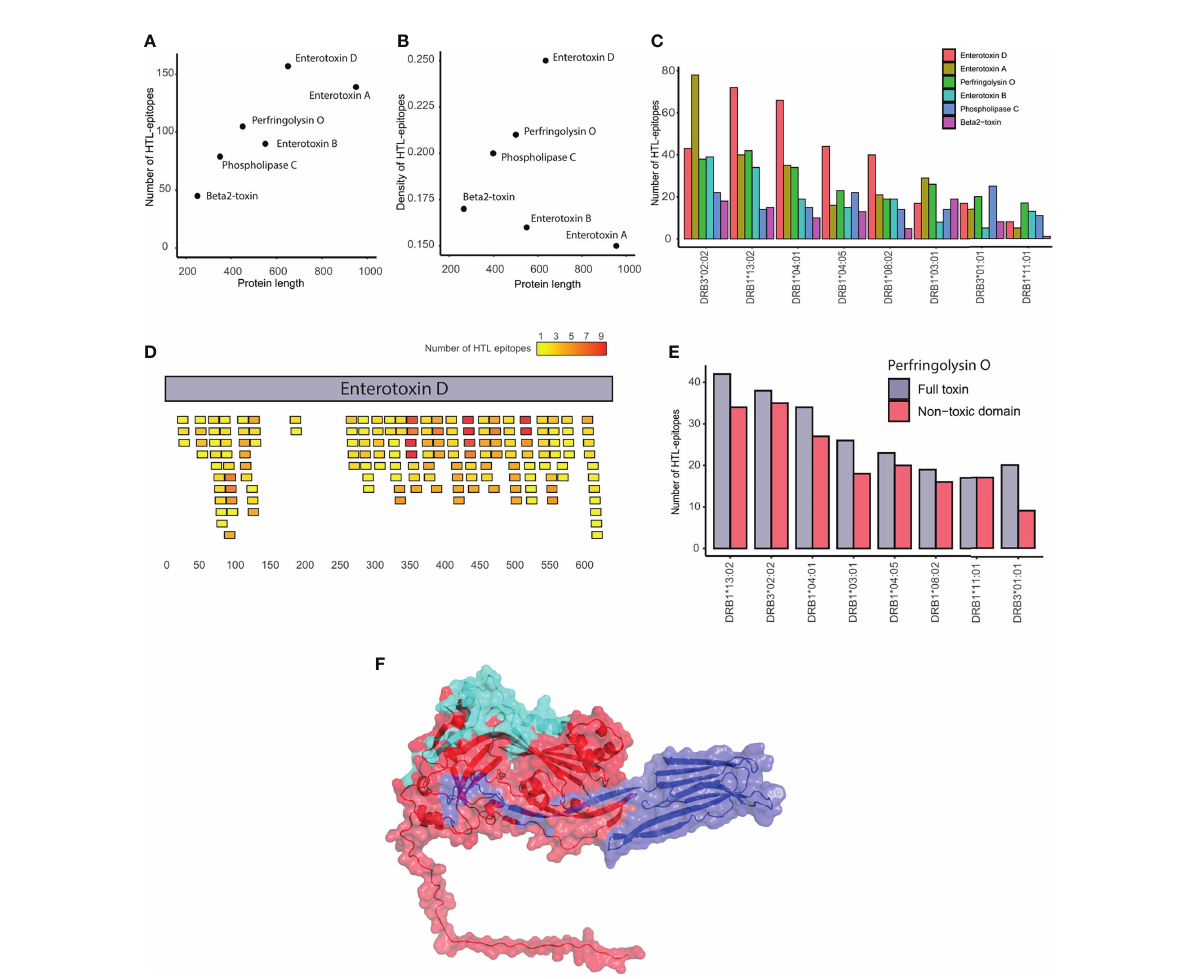
FIGURE 3 Evaluation of epitopes in C. perfringens toxins. (A) Correlation between the number of HTL-epitopes and protein length. (B) Correlation between HTL-epitope density and protein length. (C) Number of HTL-epitopes within toxins binding each of the HLA-II supertype alleles. (D) Location of the HTL-epitopes along the enterotoxin (D) Epitopes are colored in a gradient from yellow to red, representing the number of HLA alleles they bind. (E) Number of HTL-epitopes in the whole Perfringolysin O toxin (in gray) and its non-toxic domain (red) that are predicted to bind each of the HLA-II supertype alleles. (F) Structure of the Per fi ngolysin O. The toxic-domain is represented in blue. The non-toxic domain in red, highlighting the most promiscuous epitopes in